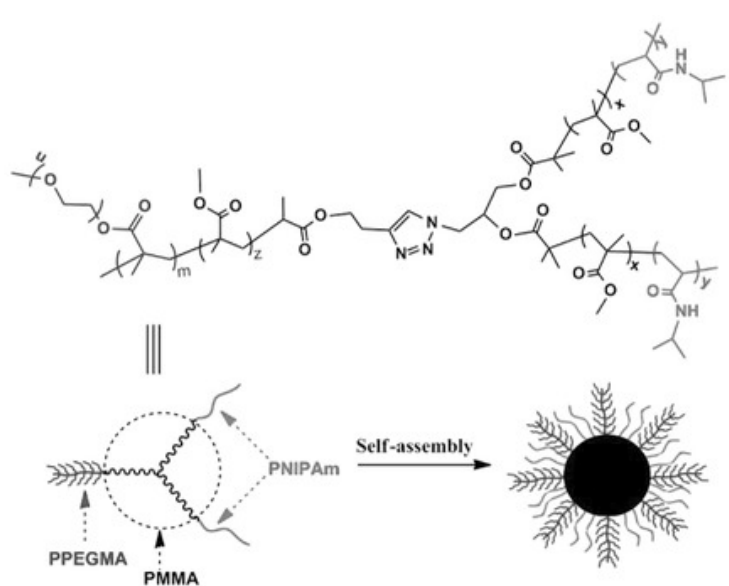
Figure 12. Schematic illustration of the micellar self-assembly of (BA)(AC) 2 miktoarm star polymers. Reprinted with permission from reference [65]. Copyright 2016 John Wiley and Sons.